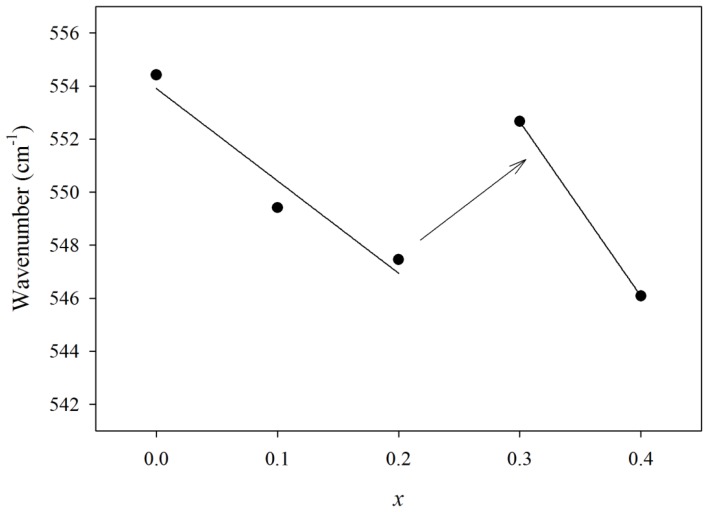
Dependence of FTIR wavenumber, located at about 550 cm−1, to bismuth composition of (GeO2)0.6(PbO)0.4 −
x(1/2Bi2O3)x glass. Bi-rich samples deviate to higher values.